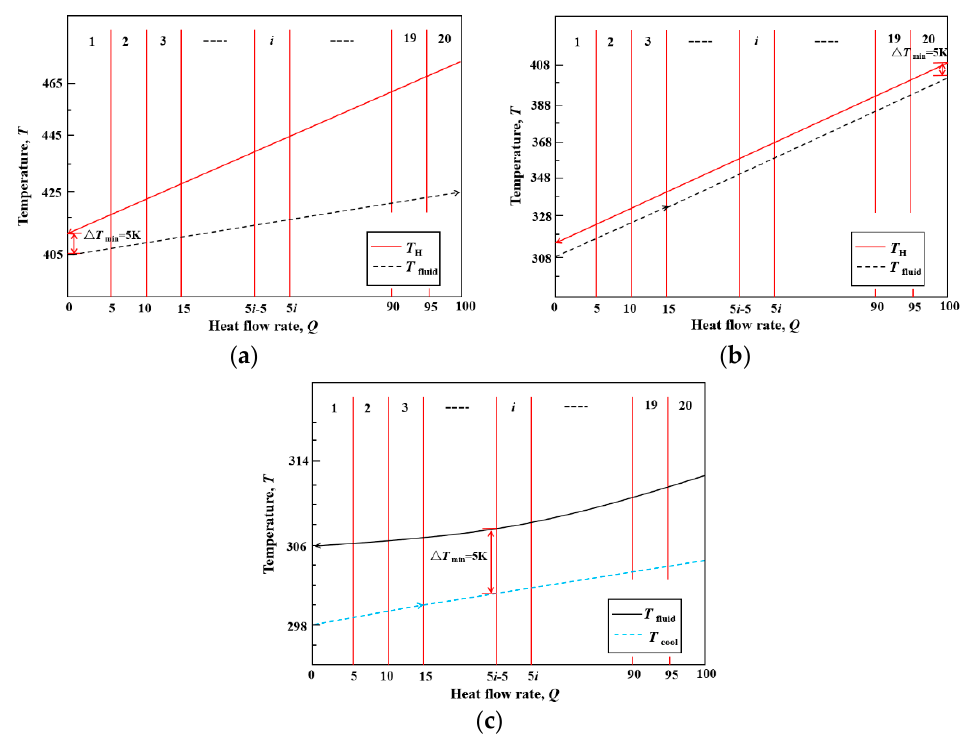
Figure 5. The T-Q diagram of the heat exchanger for the OFRC system:( a ) the heater I; ( b ) the heater II; ( c ) the condenser.